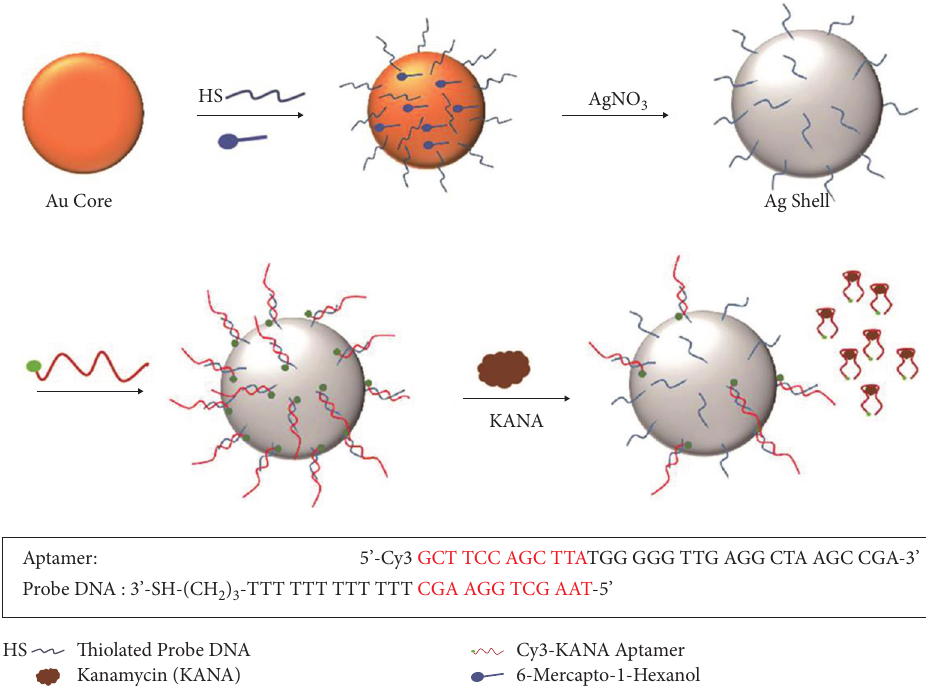
Figure 5: Schematic of the SERS-based method for KANA detection using double-strand DNA aptamer-bonding Au@Ag NPs